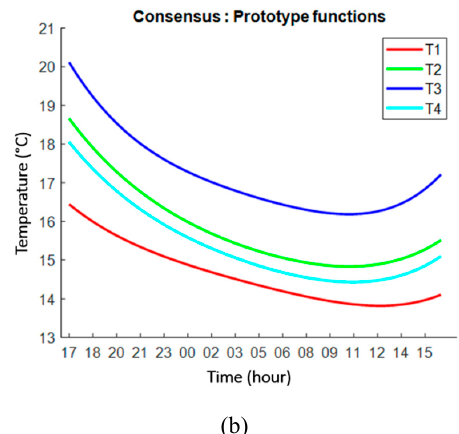
Figure 18. 3D-TTA Module 3.2: Segmentation into regions through a temporal analysis of thermal maps. ( a ) The test wall and visualization of the segmented regions in different colors. ( b ) Corresponding prototype vectors are in the same colors.